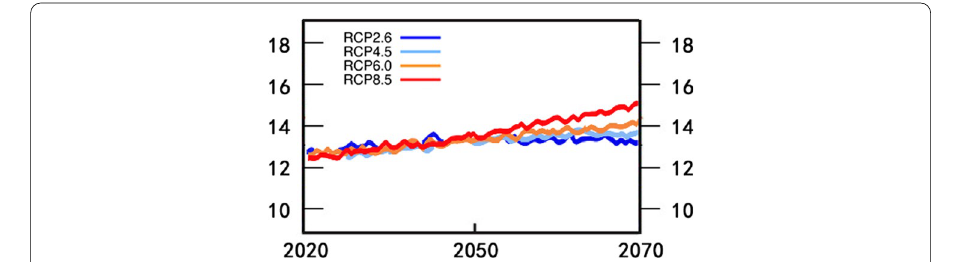
Fig. 3 Results of SST variation under the influence of different RCPs